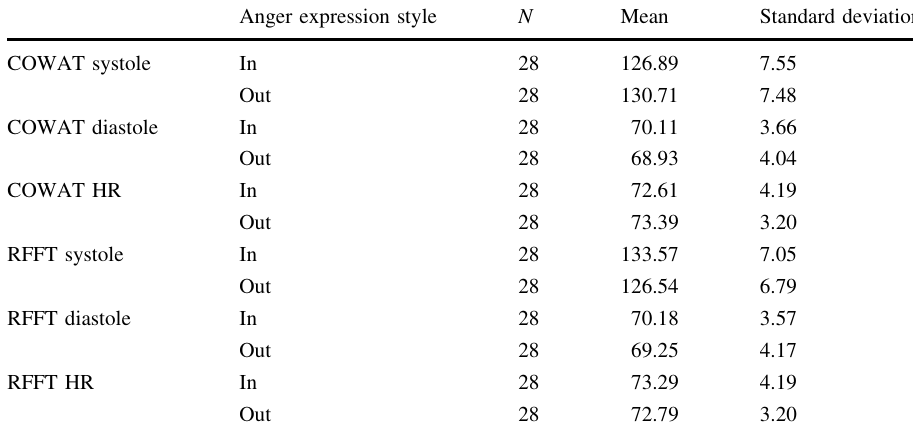
Anger expression style